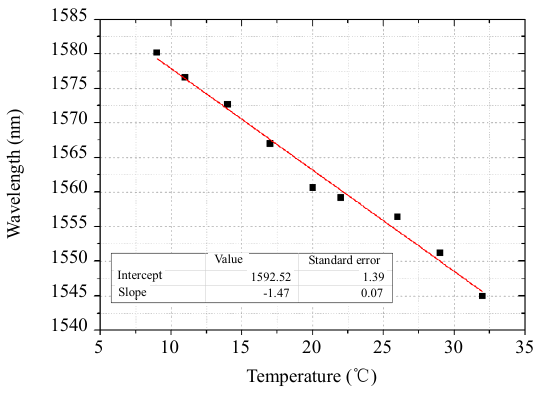
Fig. 4 Shifted resonant wavelength plotted with operation